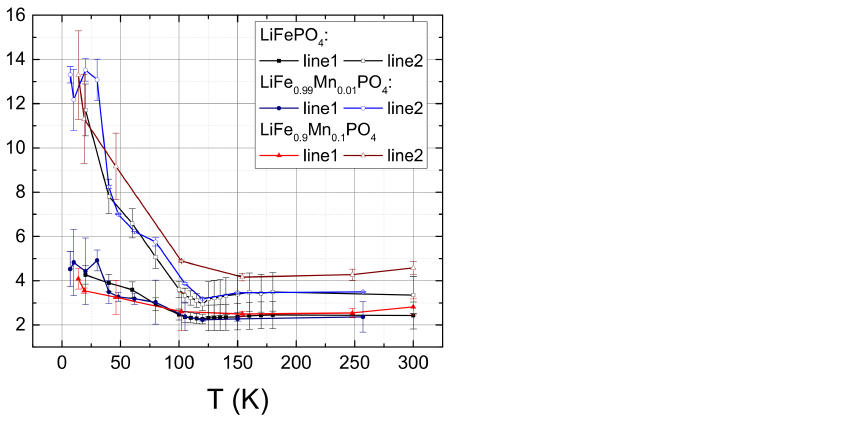
Figure 6. Temperature dependence of the g-factor of resonance signals in LiFe 1 − x Mn x PO 4 (x = 0, 0.01, 0.1).